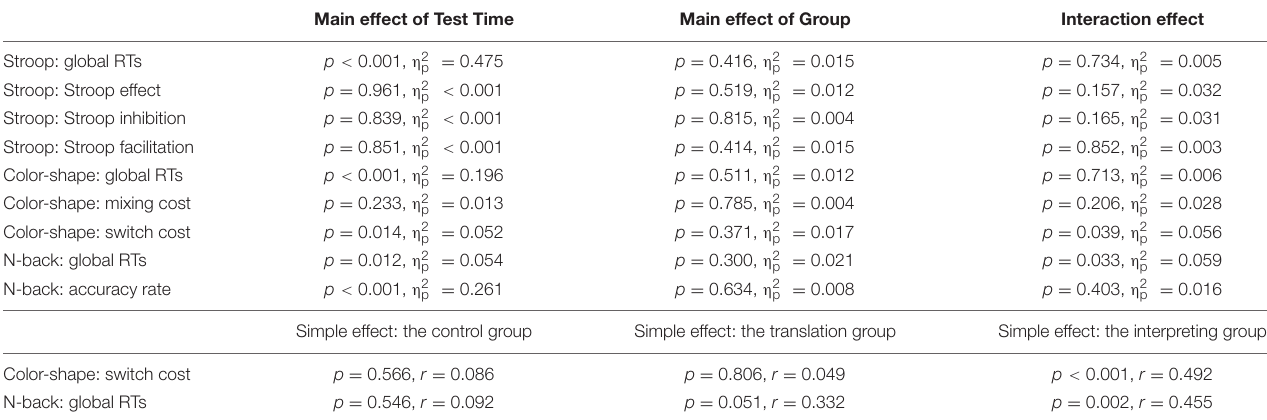
TABLE 6 | Summary of Group × Test Time analyses in each task index of the cognitive control